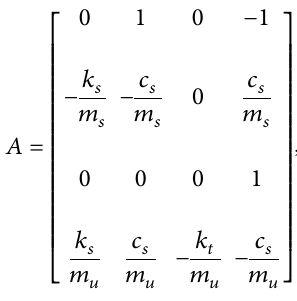
Figure 2: Structure of the EMLHAS actuator.